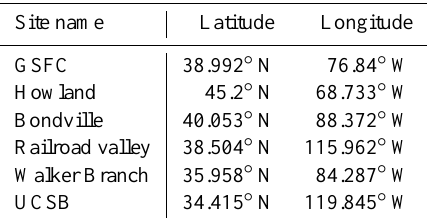
Table 1. Geographical locations of the AERONET